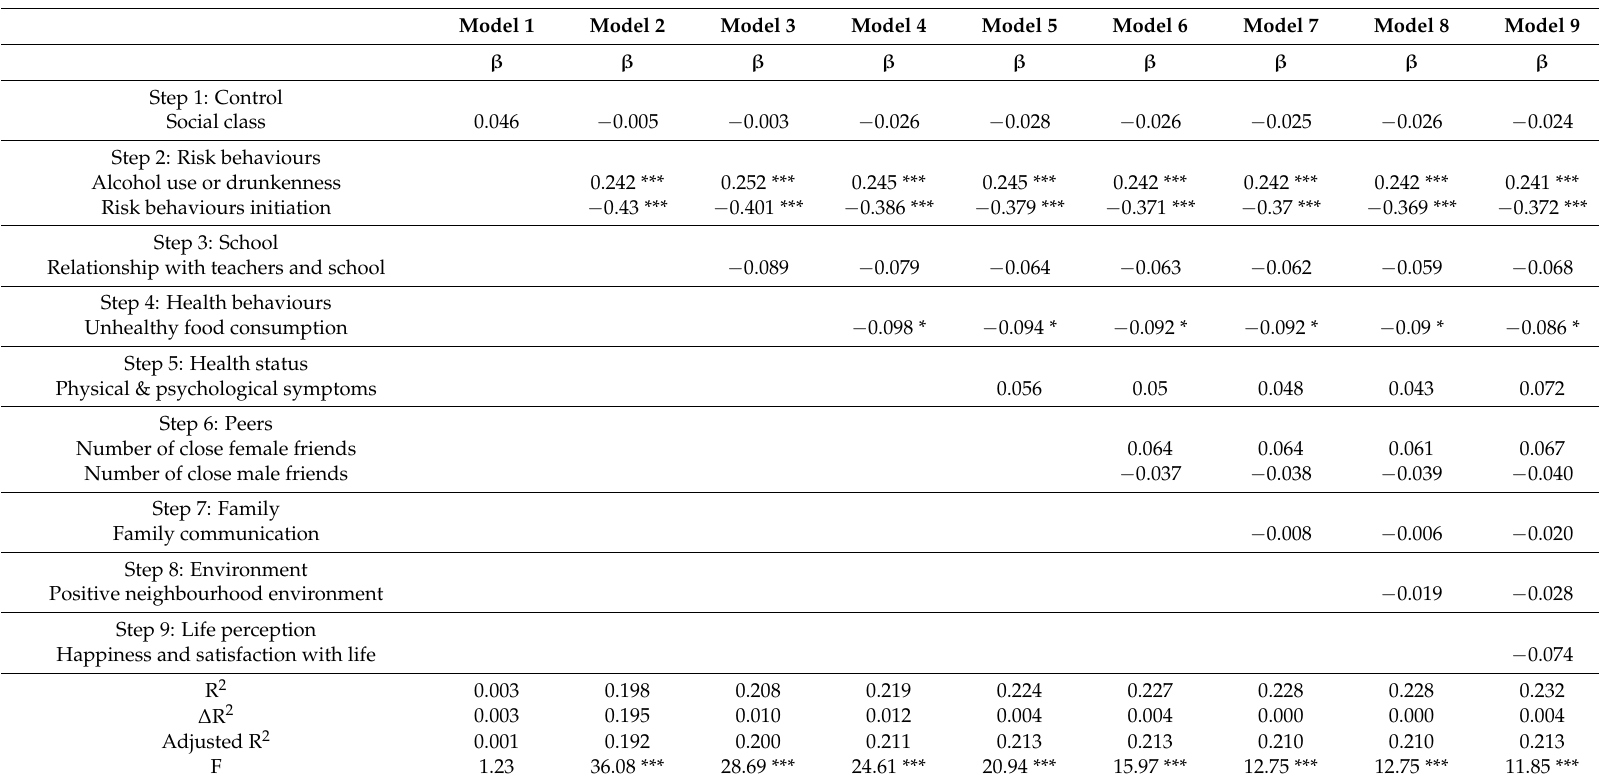
Table 3. Hierarchical linear regression model results, predictors of age of sexual initiation among